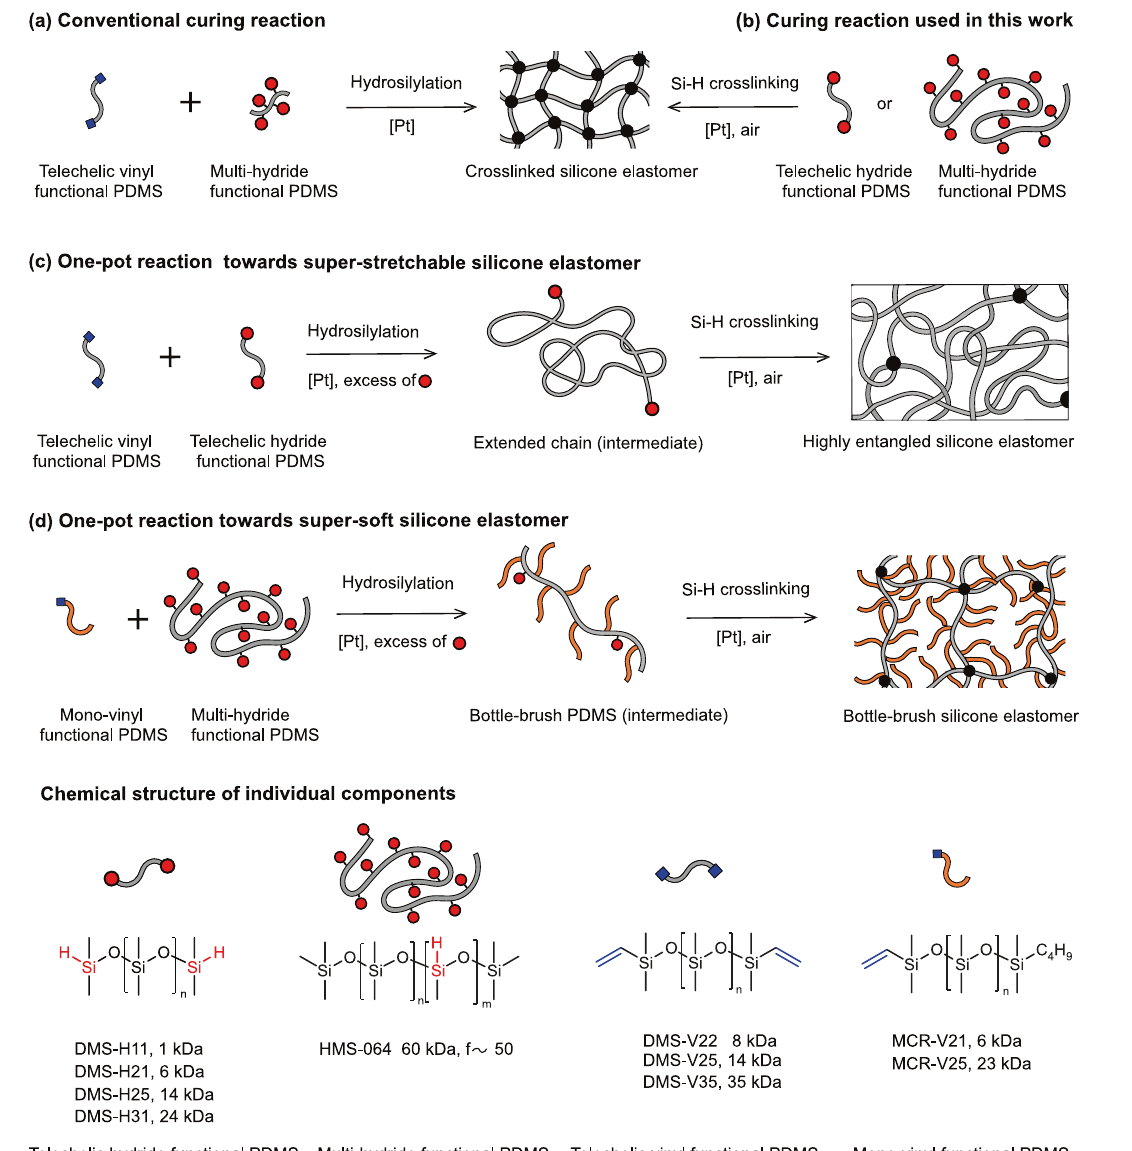
Fig. 1 Various curing reactions to prepare silicone elastomers. a Conventional curing reaction to prepare silicone elastomers. 8 b Curing reaction used in this study to prepare silicone elastomers. c Highly stretchable silicone elastomers and d extremely soft silicone elastomers prepared from a one-pot curing reaction by combining hydrosilylation and subsequent Si – H crosslinking